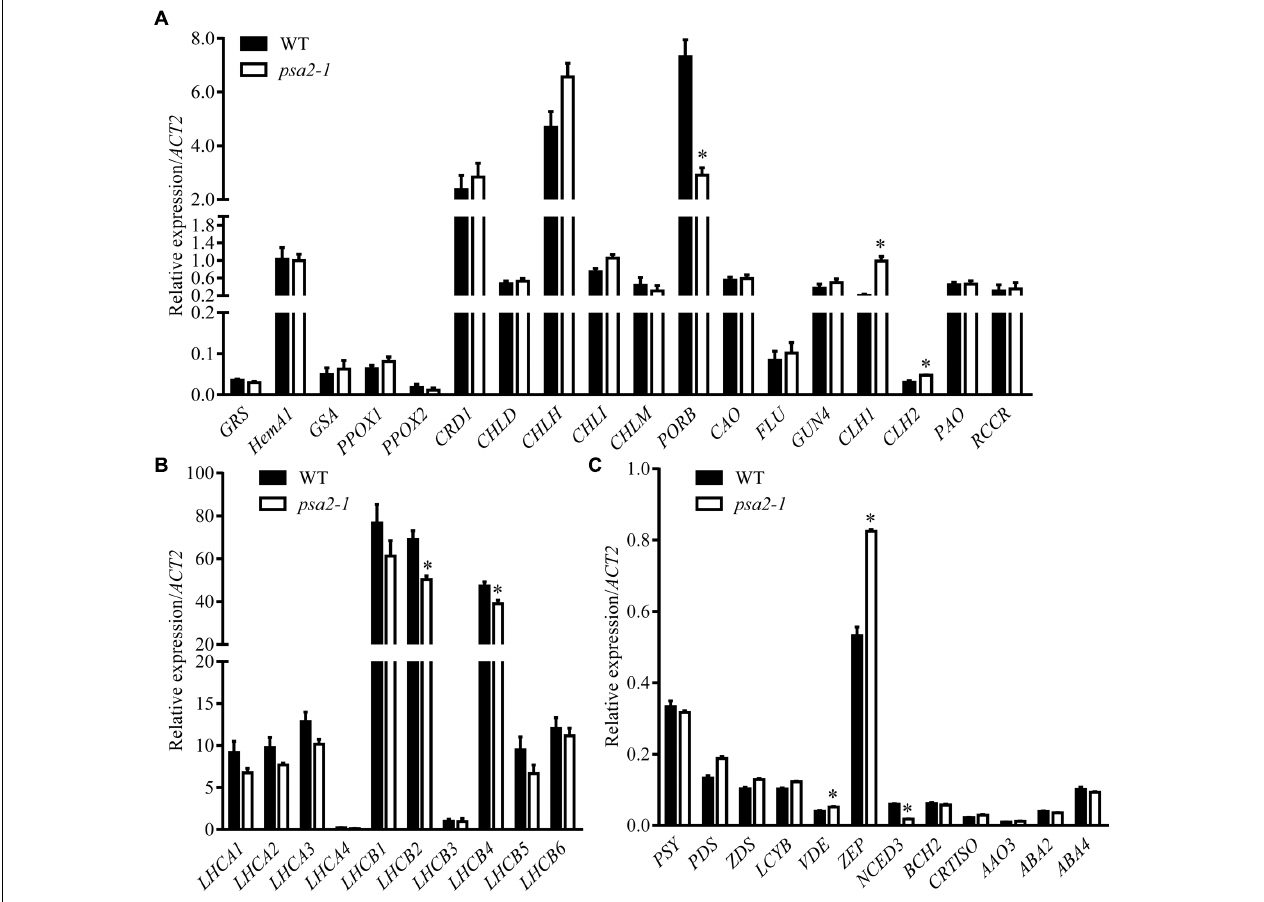
FIGURE 7 | Expression of the genes encoding enzymes for chlorophyll metabolism (A), chlorophyll binding proteins (B) and enzymes for carotenoid metabolism (C) in rosette leaves of the 4-week-old psa2-1 and wild-type (WT) seedlings. Transcript abundance of each gene was quantified by quantitative real-time PCR and are expressed relative to ACT2 ( At3g18780 ). Data represent means ± SE (Student’s t test; n = 6. ∗ P <